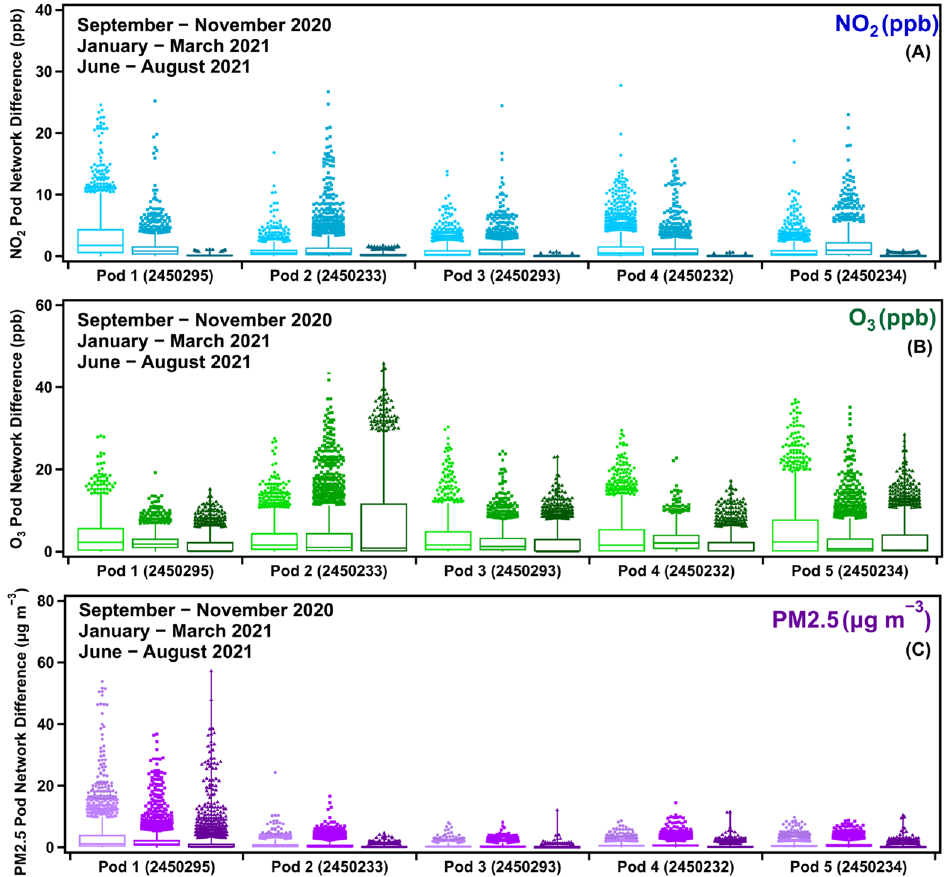
Figure 5. Pod network difference values obtained from the custom-made long distance scaling tool to highlight the outlier data points observed for each pod throughout the Fall 2020, Winter 2021, and Summer 2021 time periods. Results were plotted for ( A ) Nitrogen Dioxide (NO 2 ), ( B ) Ground-level Ozone (O 3 ), and ( C ) Fine Particulate Matter (PM2.5). Note Pod 4 September–November 2020 was in a different location than the other two periods.